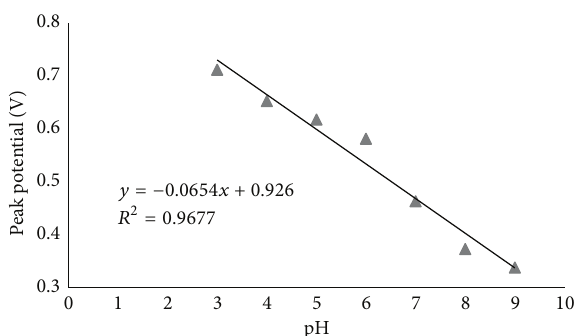
Figure 9: A plot of anodic peak potential for the electrochemical reaction of 0.1 mM paracetamol in various pH of 0.1 M KH 2 PO 4 electrolytesolutionataSWCNT/Ni/GCE.Scanrate: 100 mVs −1 .pH: 3–9.